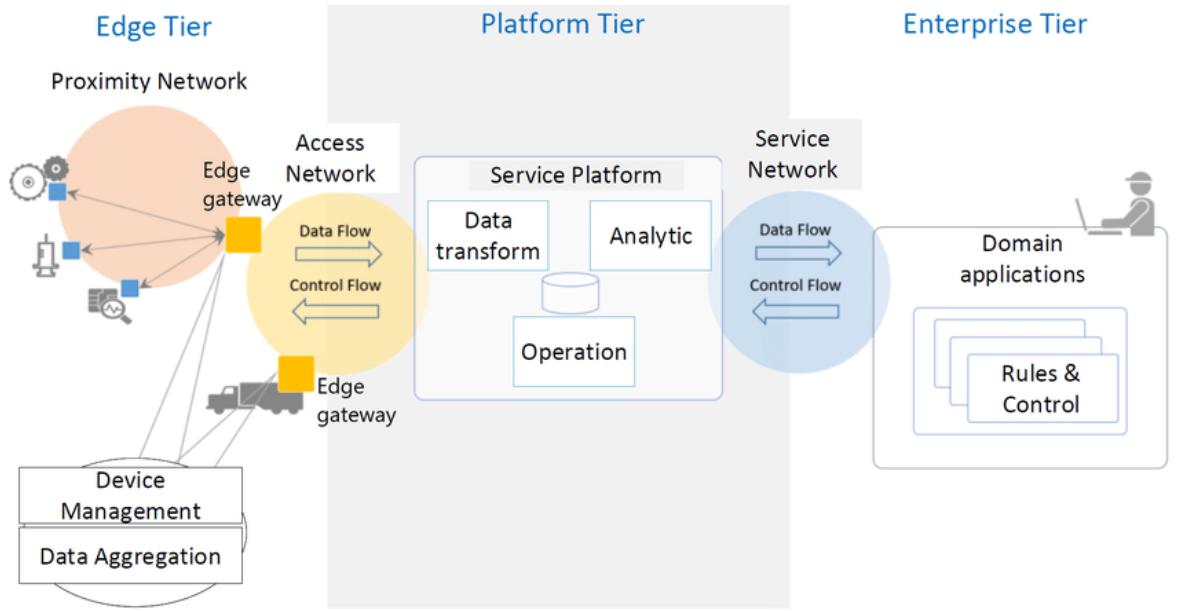
Figure 4. Three-Tier IIoT system architecture of IIRA (Reprinted with permission from [11]. Copyright 2019 Object Management